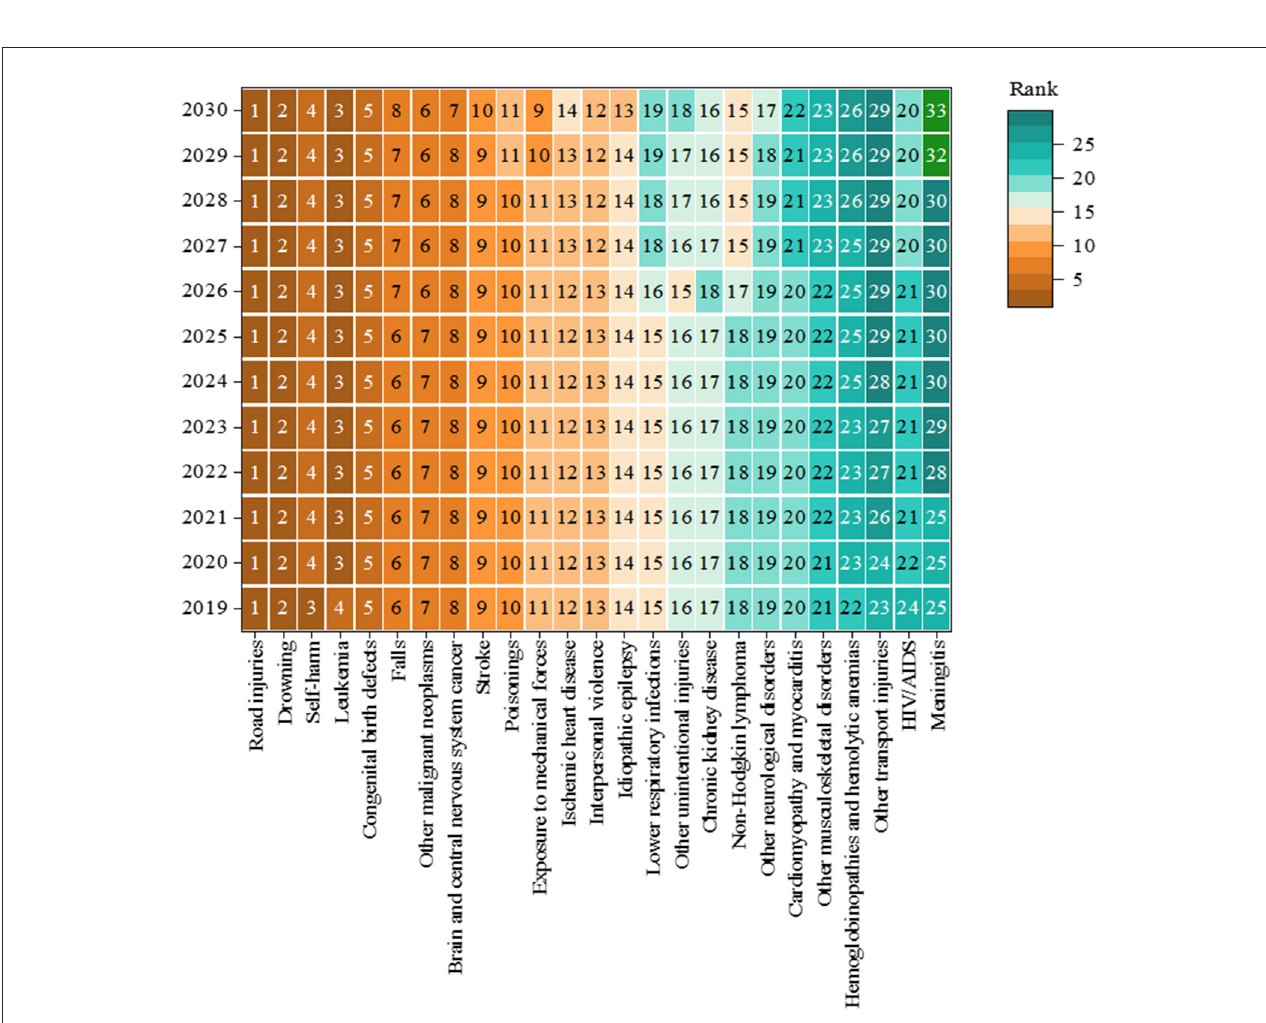
FIGURE7 Rank of the top 25 causes of death in China, aged 10–19 years, both sexes from 2019 to